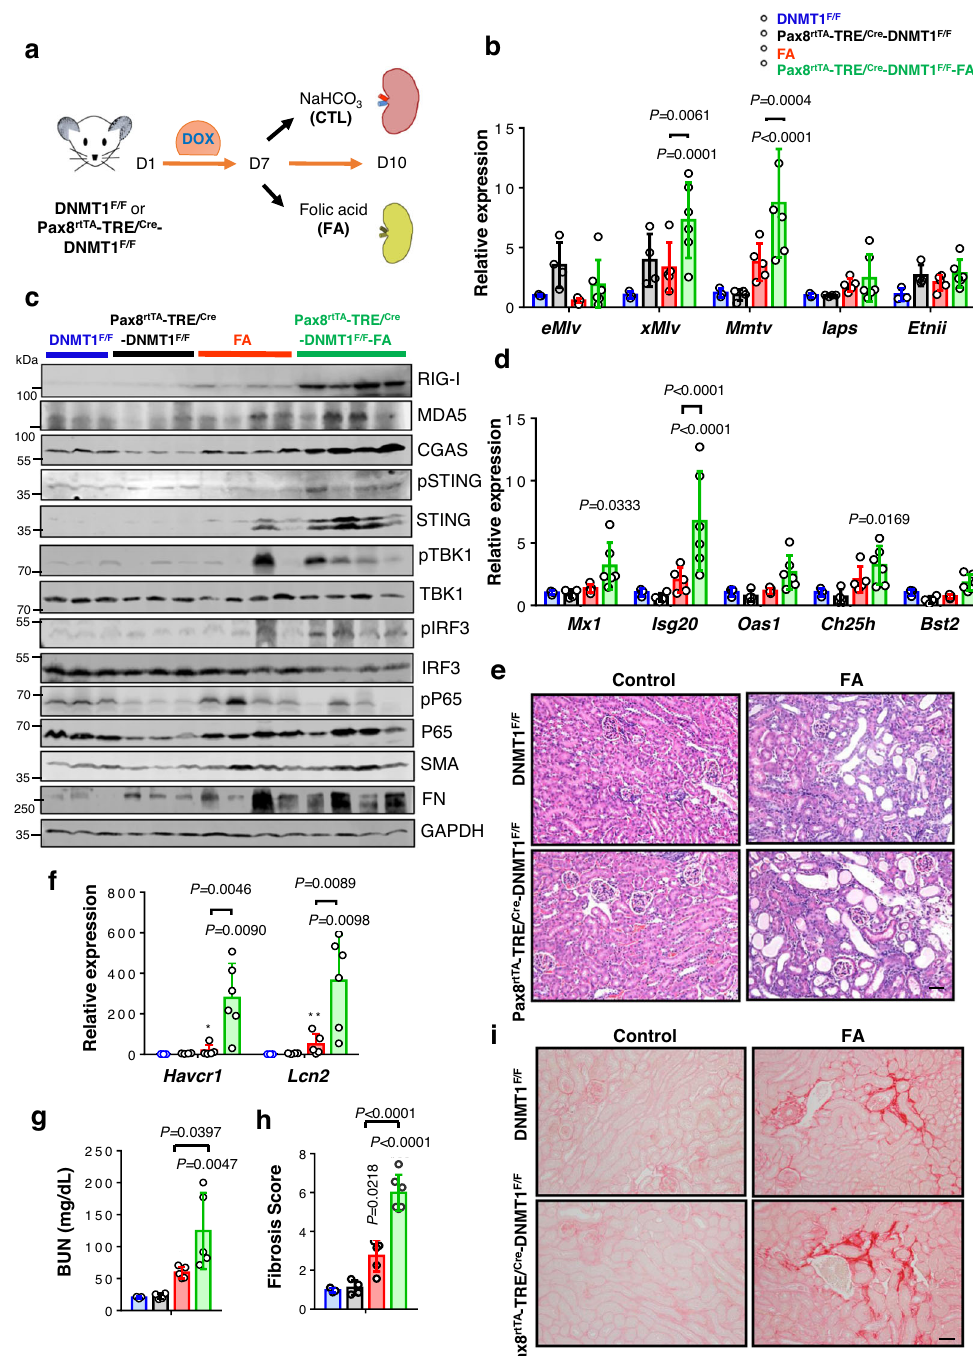
Fig. 6 | Conditional inducible genetic deletion ofDNMT1 in kidneytubule cells will lead to increased TE and ERV expression and more severe kidney injury. a Experimental design. b Relative mRNA levels of Class I ERVs ( eMlv, xMlv , and Mmtv ) and Class II ERVs( Iaps and Etnii) in kidneys ofDNMT1 F/F and Pax8 rtTA /TRE Cre / DNMT1 F/F mice injected with FA or vehicle (DNMT1 F/F (blue), n =3; Pax8 rtTA /TRE Cre / DNMT1 F/F (black), n =4; FA (red), n =5; Pax8 rtTA /TRE Cre /DNMT1 F/F FA (green), n =6). c Western blot showing representative images of RIG-I, cGAS, pSTING, STING, pTBK1, TBK1, pIRF3, IRF3, pP65, P65, SMA, and FN protein levels in kidneys of DNMT1 F/F and Pax8 rtTA /TRE Cre /DNMT1 F/F mice injected with FA or vehicle. GAPDH was used as a loading control. d Relative mRNA levels of ISGs ( Mx1, Isg20, Oas1, Ch25h ,and Bst2 )inkidneysofDNMT1 F/F andPax8 rtTA /TRE Cre /DNMT1 F/F miceinjected with FA or vehicle. (DNMT1 F/F , n =3; Pax8 rtTA /TRE Cre /DNMT1 F/F , n =4; FA, n =5; Pax8 rtTA /TRE Cre /DNMT1 F/F FA, n =6). e Representative hematoxylin and eosin (H&E) staining of kidneys from DNMT1 F/F , Pax8 rtTA /TRE Cre /DNMT1 F/F mice treated with FA